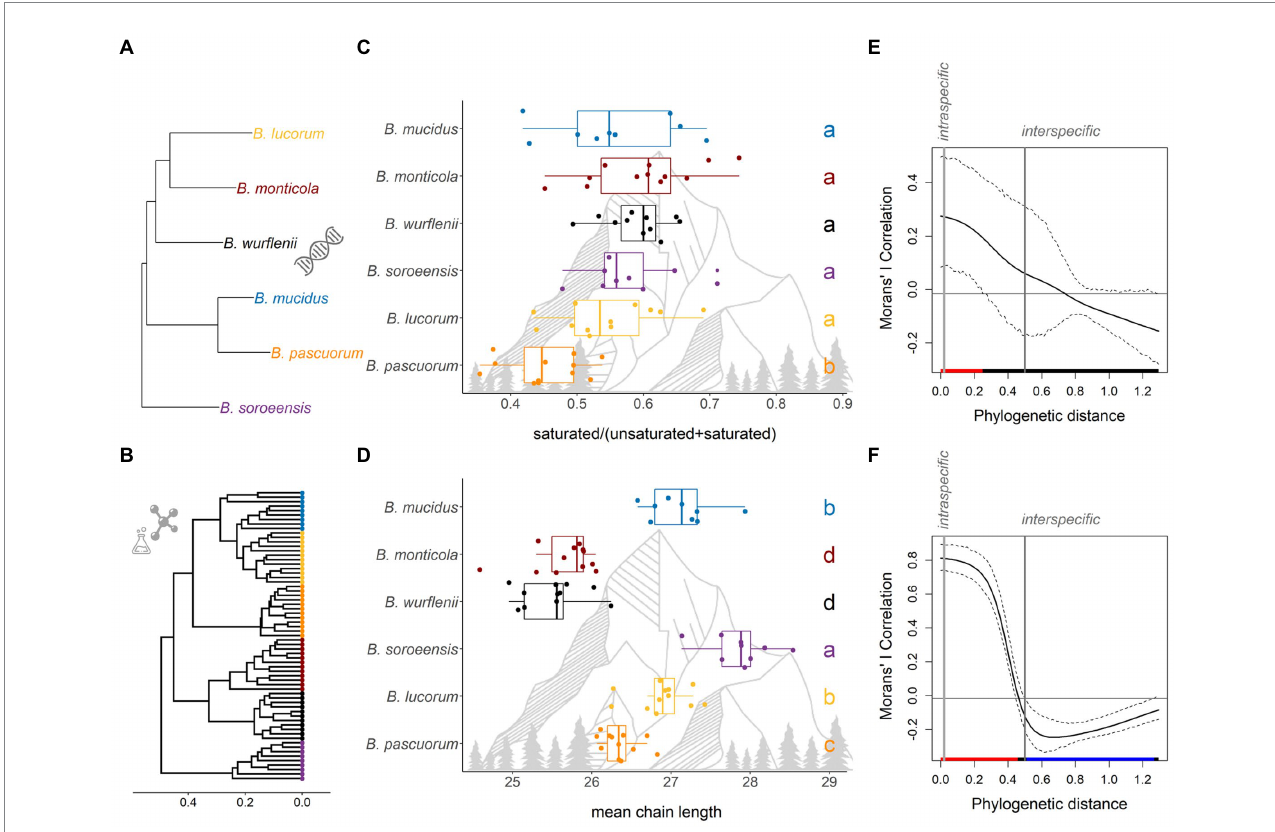
FIGURE 2 Interspecific differences and phylogenetic signals in climate-associated chemical traits of six bumble bee species. (A) Phylogenetic tree extracted from phylogeny of bumble bees estimated from Bayesian analysis of combined sequence data from five gene fragments (16S, opsin, ArgK, EF-1 α , and PEPCK) by Cameron et al. (2007). (B) Individual-based Cluster dendrogram showing the similarity of the total CHC profiles composition based on Bray-Curtis distances. (C) Proportion of saturated components and (D) mean chain lengths within the CHC profiles of six bumble bee species. Letters indicate significant differences between species. (E,F) Phylogenetic correlograms for the two traits are presented: (E) proportion of saturated components, (F) mean chain length. The solid bold black line shows the Moran’s I index of autocorrelation, and the dashed black lines the lower and upper bounds of the 95% confidence interval. The horizontal black line indicates the expected value of Moran’s I under the null hypothesis of no phylogenetic autocorrelation. The colored bar shows whether the autocorrelation is significant (based on the confidence interval): red for significant positive autocorrelation, black for nonsignificant autocorrelation, and blue for significant negative autocorrelation. The vertical gray lines indicate the predefined intraspecific distance (0.02) and the interspecific distance ( ≥ 0.5). Thus, the interpretation of modeled Moran’s I index is limited between a phylogenetic distance of 0.02 and